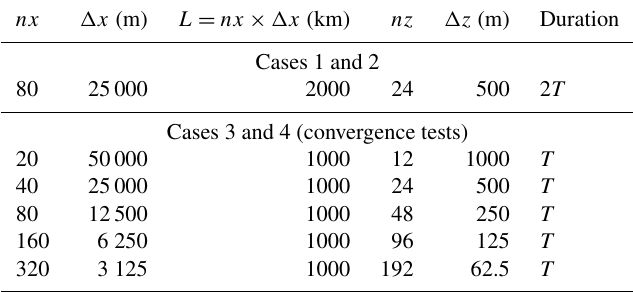
Table 2. Domain resolution and size for Cases 1 and 2; set of increasing resolutions used for convergence tests (Cases 3 and 4). For all configurations, nz ∗ (cid:49)z = 12000m is the domain vertical extension.